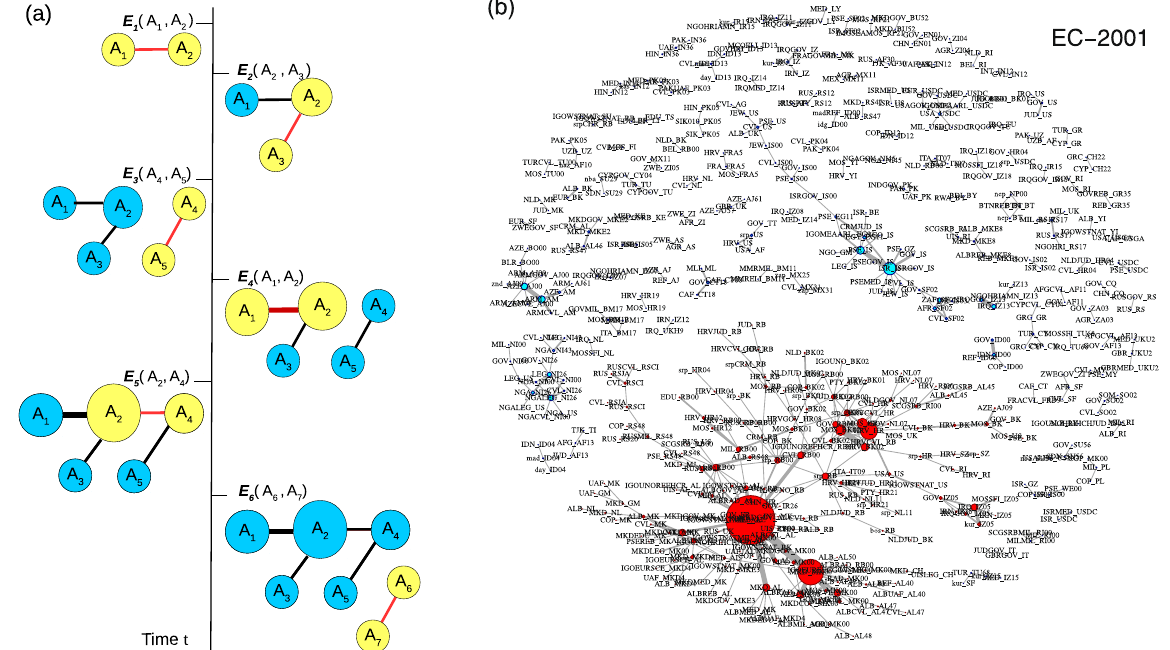
Figure 2. ( a ) The schematic visualization of events on a time-line and the subsequent evolution of the aggregated network of actors: Events appear sequentially. Event E 1 involving actors A 1 , A 2 is followed by event E 2 involving A 2 , A 3 and so on. The links depict the actors involved together in an event. New events (actors in yellow and links in red) add to actor mention (size of node) and actor co-mention (link weight; thickness of links). ( b ) The network of actors for EC for 2001. Each actor is a node and any two actors ever involved in an event are connected by a link. The size of the nodes are proportional to the total number of mentions in the period, and the relative thickness of the links are proportional to the total number of co-mentions of the actors (link weights). The largest connected component (giant component) is depicted in